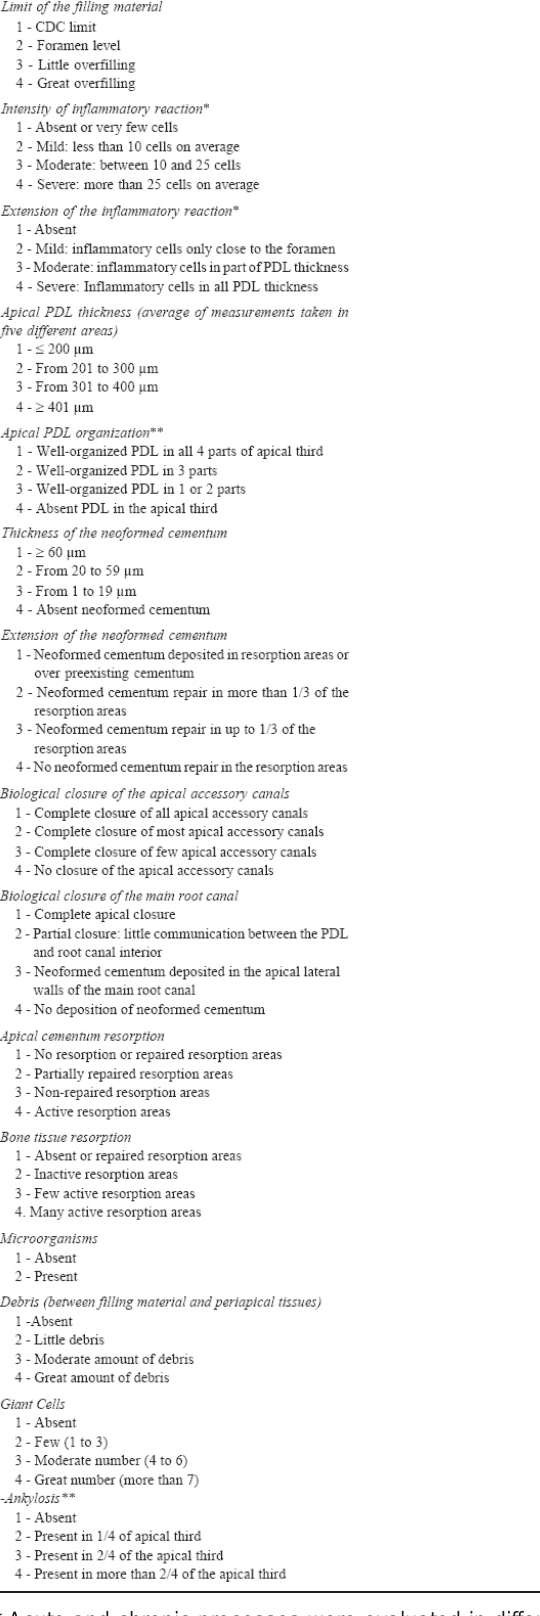
TABLE 1- Histomorphologic parameters and scores